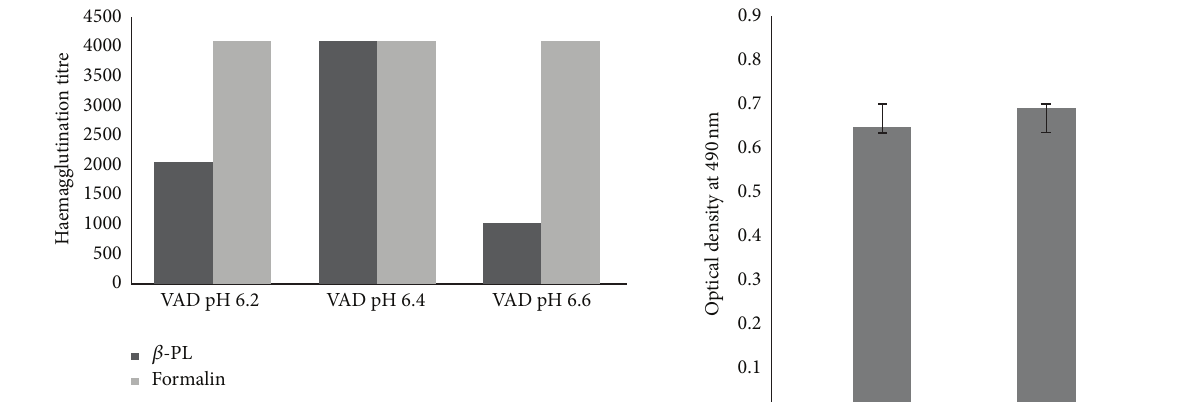
Figure 1: Haemagglutination titre of prepared WNV antigen by two different inactivating agents: 𝛽 -PL and formalin at VAD of pH 6.2, 6.4, and 6.6. Figure 2: Antigenicity of 𝛽 -PL and formalin inactivated WN preparations evaluated by indirect ELISA.